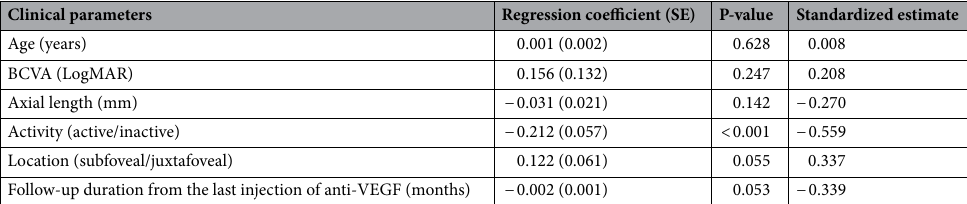
Table 4. Univariate linear regression analyses of the median size of the choriocapillaris flow deficit and other factors in optical coherence angiography of myopic choroidal neovascularization. SE standard error, OCTA